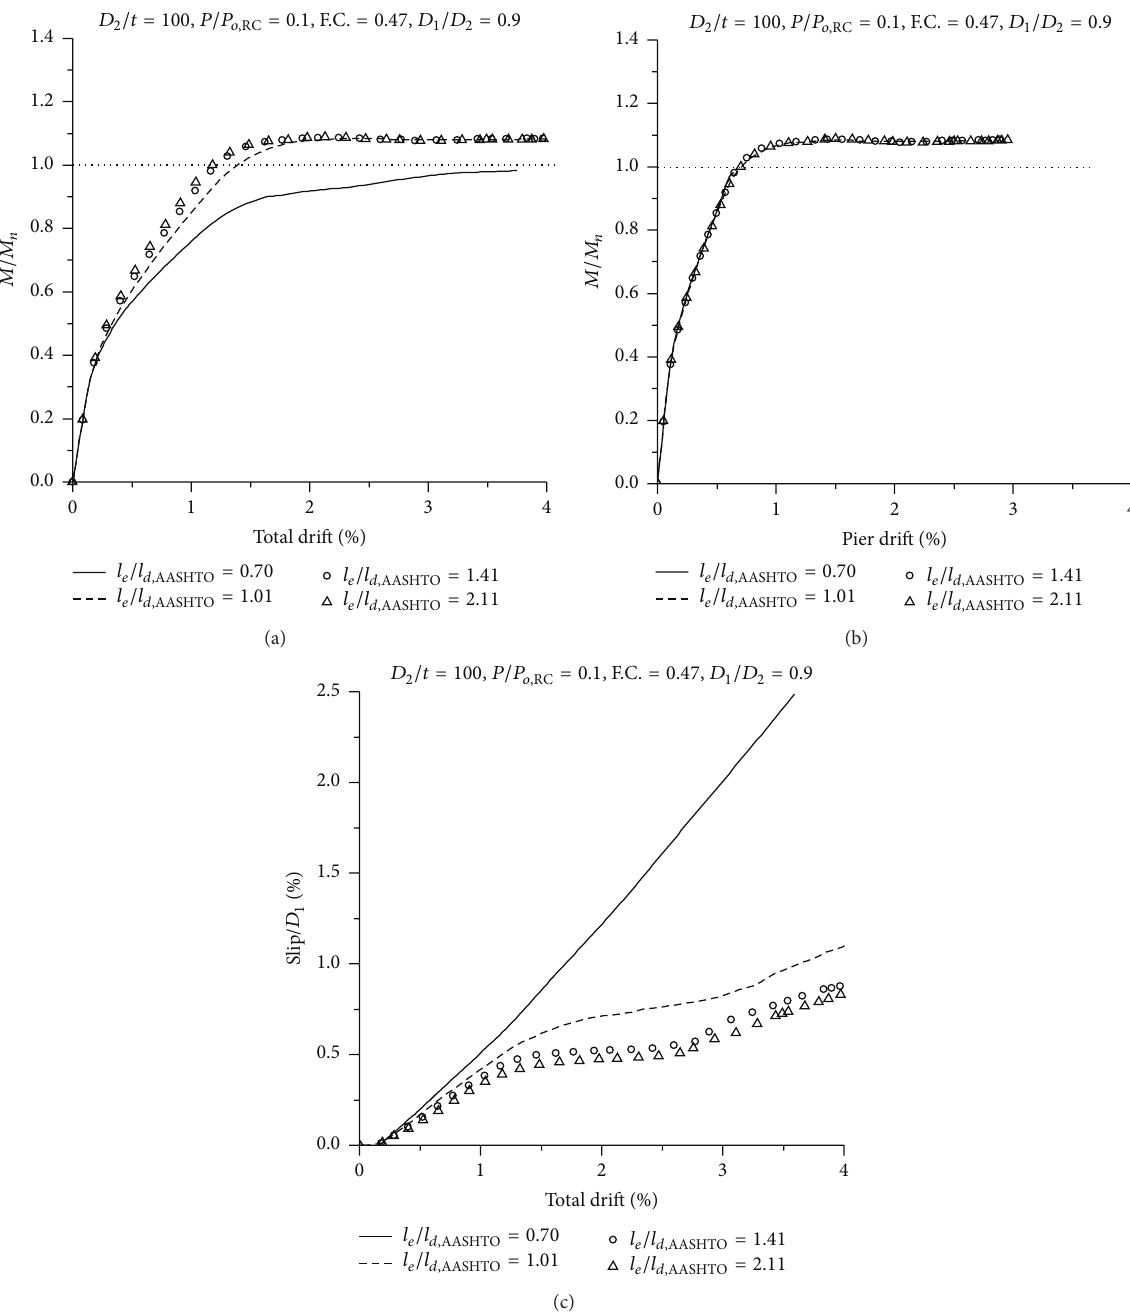
Figure 9: Effect of 𝑙 𝑒 : (a) 𝑀/𝑀 𝑛 vs. total drift; (b) 𝑀/𝑀 𝑛 vs. pier drift; and (c) Slip /𝐷 1 vs. total drift.